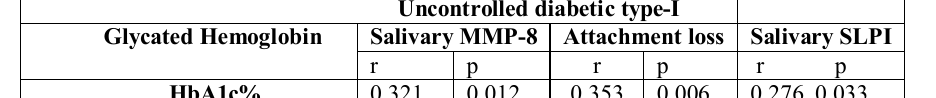
Table 5: Correlation coefficients between salivary parameters (MMP-8, SLPI) among